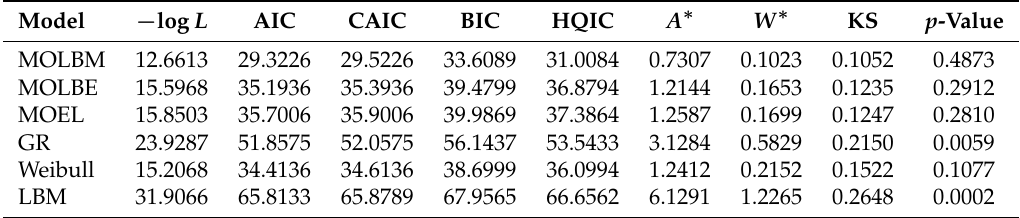
Table 14 indicates the − log L , AIC, CAIC, BIC, HQIC, A ∗ , W ∗ , KS and p -value of the considered models. Table 14. Some criteria and goodness of fit measures for Data set